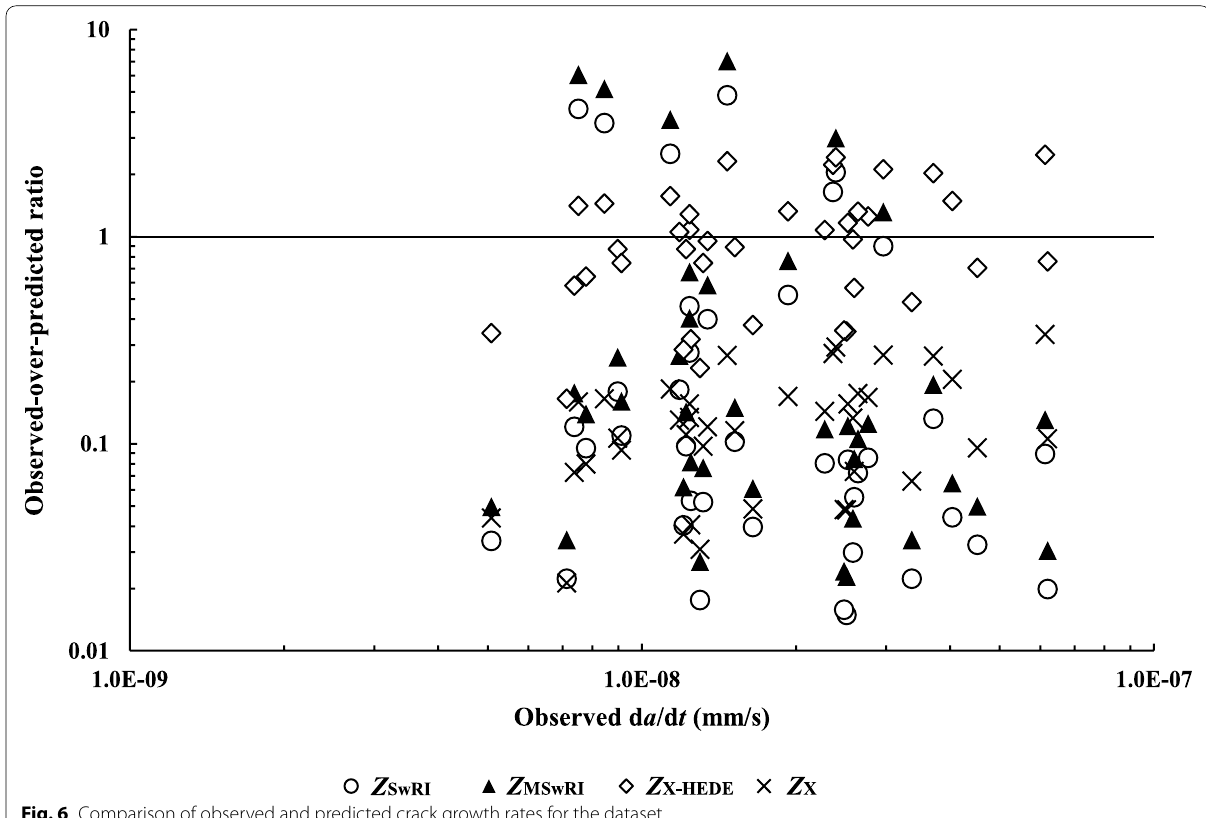
Fig. 6 Comparison of observed and predicted crack growth rates for the dataset